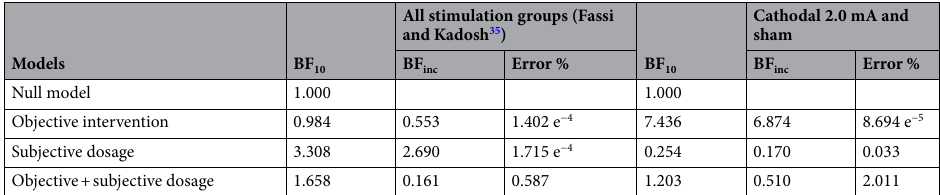
Table 3. Comparison of the summarised Bayesian ANOVA of objective intervention and subjective dosage findings from Fassi and Kadosh 35 and the present study evaluating cathodal 2.0 mA stimulation only.